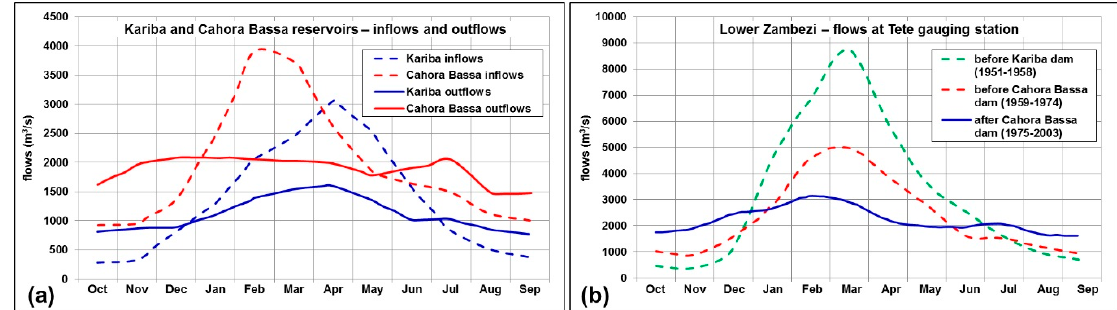
Figure 3. ( a ) Mean monthly inflows and outflows at the Kariba and Cahora Bassa dams; data from [5]. ( b ) Mean monthly discharges at the Tete gauging station; data from [15].